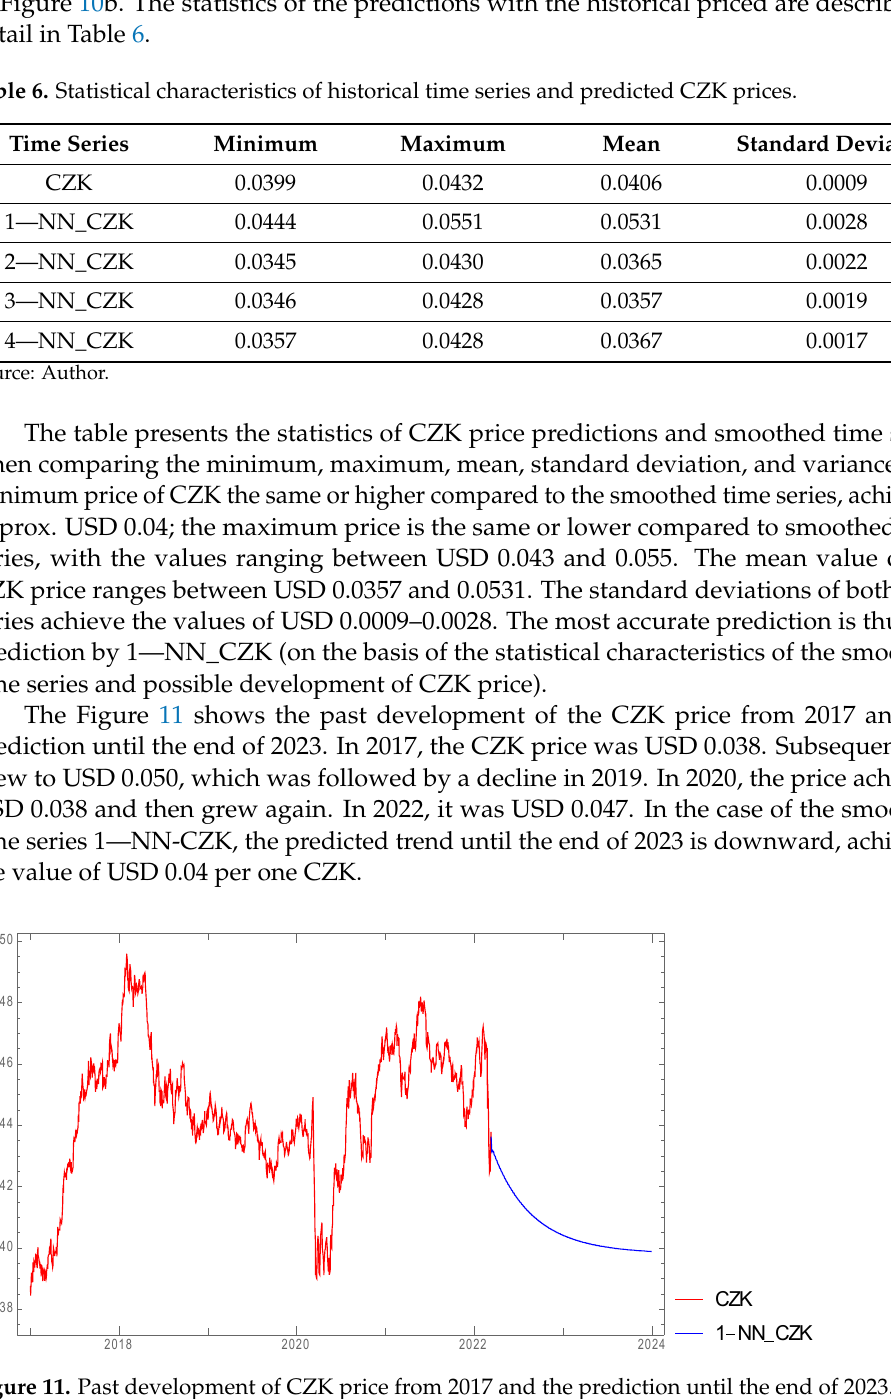
Figure 11. Past development of CZK price from 2017 and the prediction until the end of 2023.